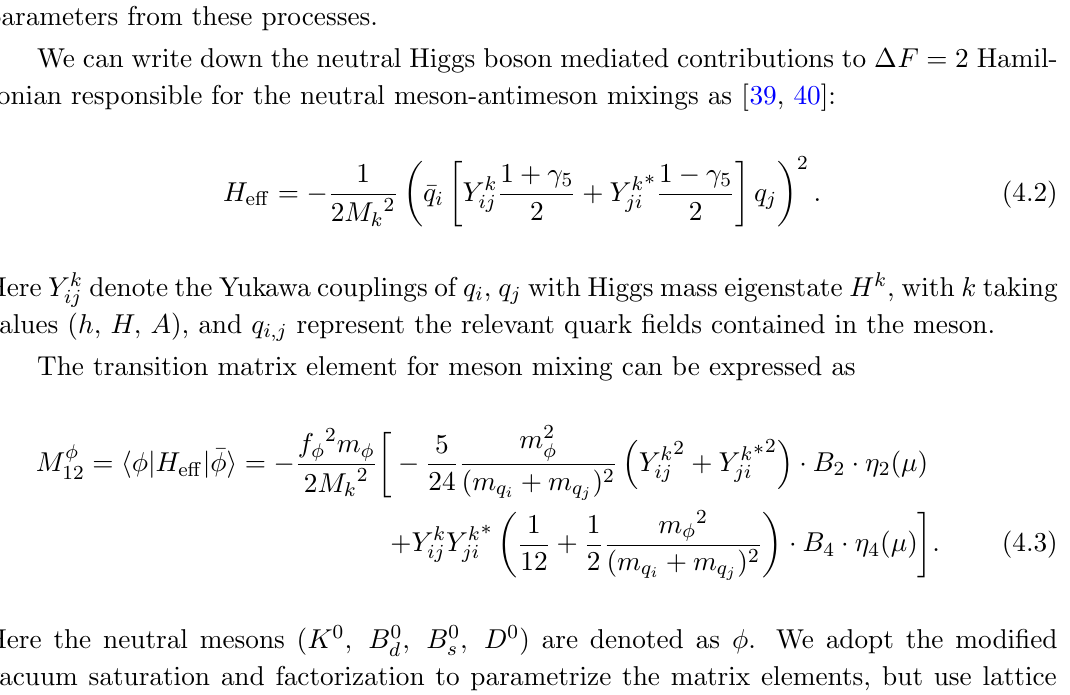
(cid:0) B 0 mixing, bottom left: B 0 s s